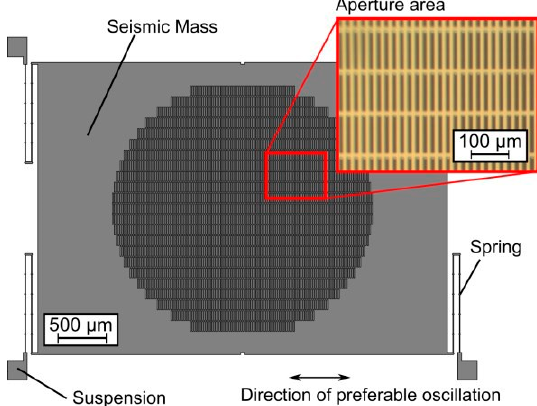
Figure 1. Schematic of the MOEMS device. A Si spring suspended seismic mass comprises rectangular aperture arrays. A glass cover on top of the structures contains the corresponding stationary chromium array (inlay, optical micrograph).